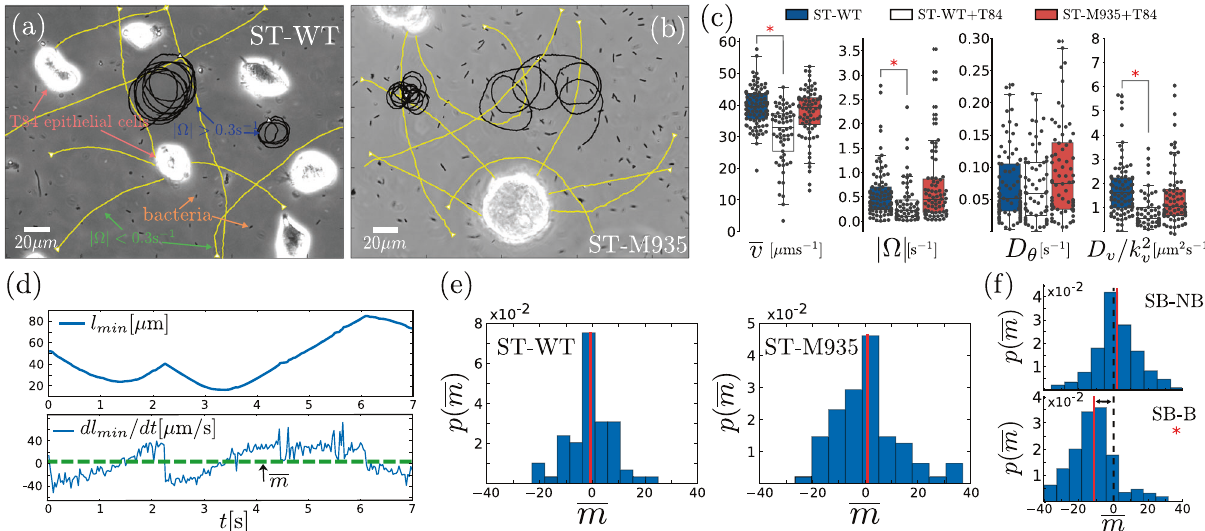
Fig. 4 Experimental trajectories in the presence of HC. a and b show snapshots of experiments with ST-WT ( a ) and non-chemotactic ST-M935 ( b ) (black dots) in the presence T84 epithelial cells as HC (bright areas). Some representative bacterial trajectories — of a population that includes motile and non- motile bacteria — are indicated by solid lines: yellow for ∣ Ω ∣ < 0.3 s − 1 and black for ∣ Ω ∣ > 0.3 s − 1 . The classi fi cation of trajectories in two categories, those with ∣ Ω ∣ smaller and larger than 0.3 s − 1 , is simply to highlight the importance of ∣ Ω ∣ . c Box plots of the (average) motility parameters in experiments: (i) with ST-WT in absence of T84 cells (ST-WT, n = 89), (ii) with ST-WT in the presence of T84 cells (ST-WT + T84, n = 60), and (iii) with the non- chemotactic mutant ST-M935 in the presence of T84 cells (ST-M935 + T84, n = 75). d illustrates the temporal evolution of the distance l min to the closest T84 cell and its derivative, m ( t ) = d l min /d t for a representative bacterial trajectory; the average of m ( t ), which is our "bias" order parameter ( (cid:2) m ) is shown as a dashed horizontal line. e The distribution of (cid:2) m in experiments, with ST-WT (left) and ST-M935 (right), in the presence of T84 cells. The vertical red lines indicate the population average. f Same as e , the method is illustrated using simulated data with (SB-B) and without (SB-NB) a chemotactic bias. The black dashed line indicates (cid:2) m ¼ 0 as a reference. Box plots: the lower and upper limit of the boxes correspond to the 25th and 75th percentiles. The line inside indicates the median. The upper and lower whiskers extend values within 1.5 IQRs. The red asterisk indicates p value < 0.01. See Supplementary Table 1 for details about the statistical